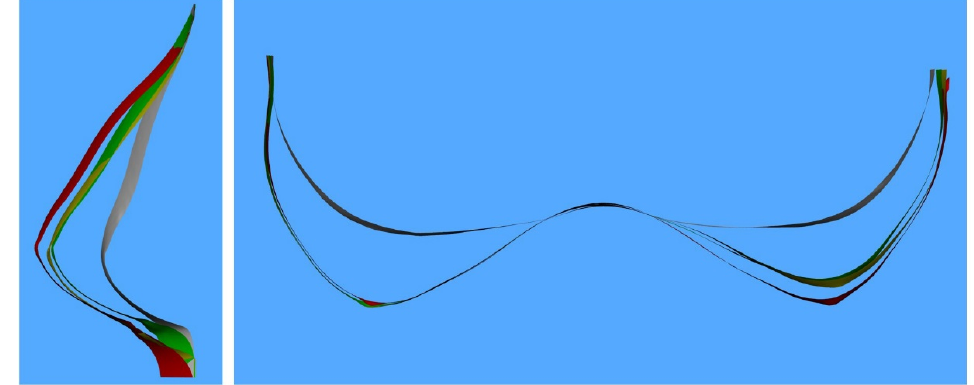
Figure 4. Digital cross-section vertically through the left NAC and horizontally through both NACs. Color-coded pre-operative ( gray ), 140 cc anatomical low-height moderate-plus sizer ( green ), a 170 cc anatomical low-height moderate-plus sizer ( yellow ) and a 225 cc round moderate-plus sizer ( red ). There was no sizer change in the right breast. Breast symmetry for implanted sizers was 4.97 ± 4.07 mm RMSE and significantly differed from breast symmetry in postoperative outcome ( p = 0.003). Table 4. Surface and volumetric changes in different sizers. Breast Difference Right-Left Breast